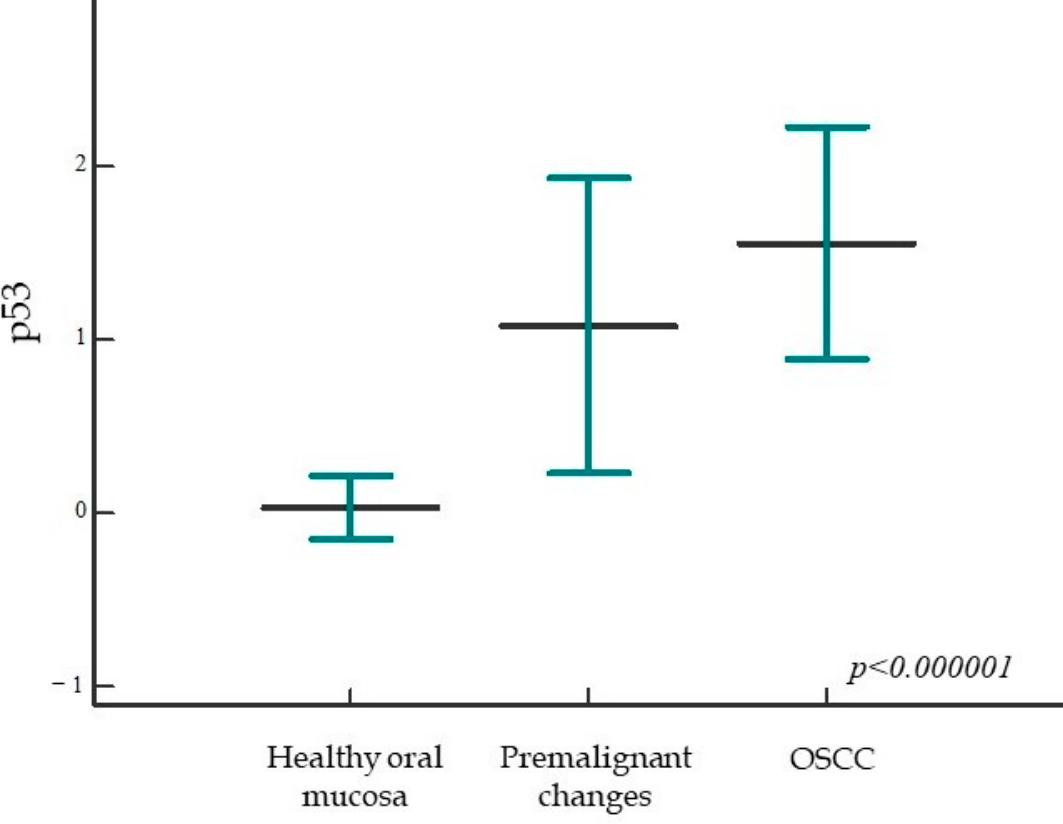
Figure 3. Expression of p53 protein in the studied groups. The percentage of p53 protein expression is significantly higher in the group of patients with premalignant changes and OSCC compared with subjects with healthy oral mucosa; moreover, a statistically significant difference was found between all studied groups ( p < 0.000001). Horizontal lines indicate mean ± standard deviation; p , significance level is marked in Kruskal–Wallis